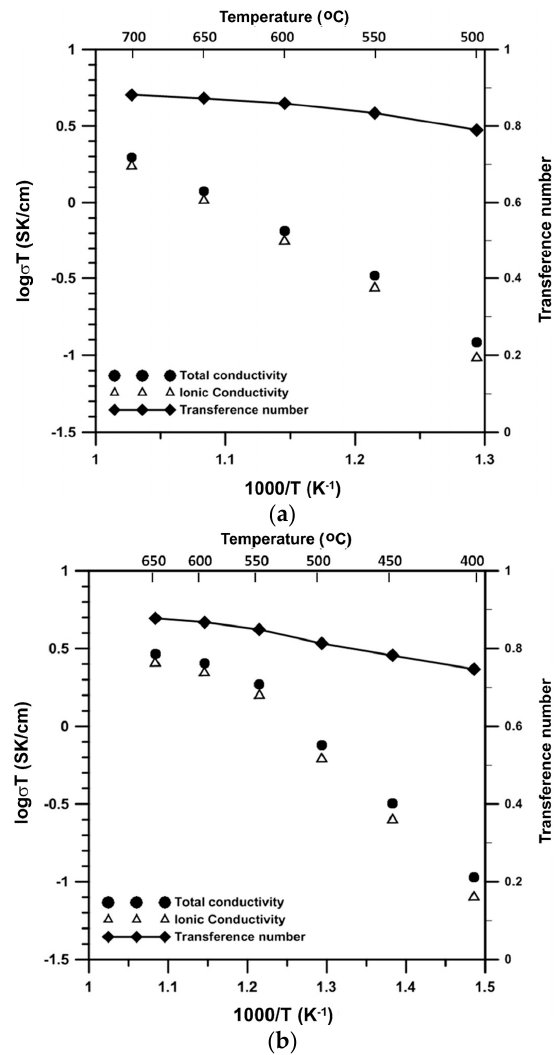
Figure 9. Ionic conductivity, total conductivity and ionic transference number of ( a ) B6V and ( b ) B8V.